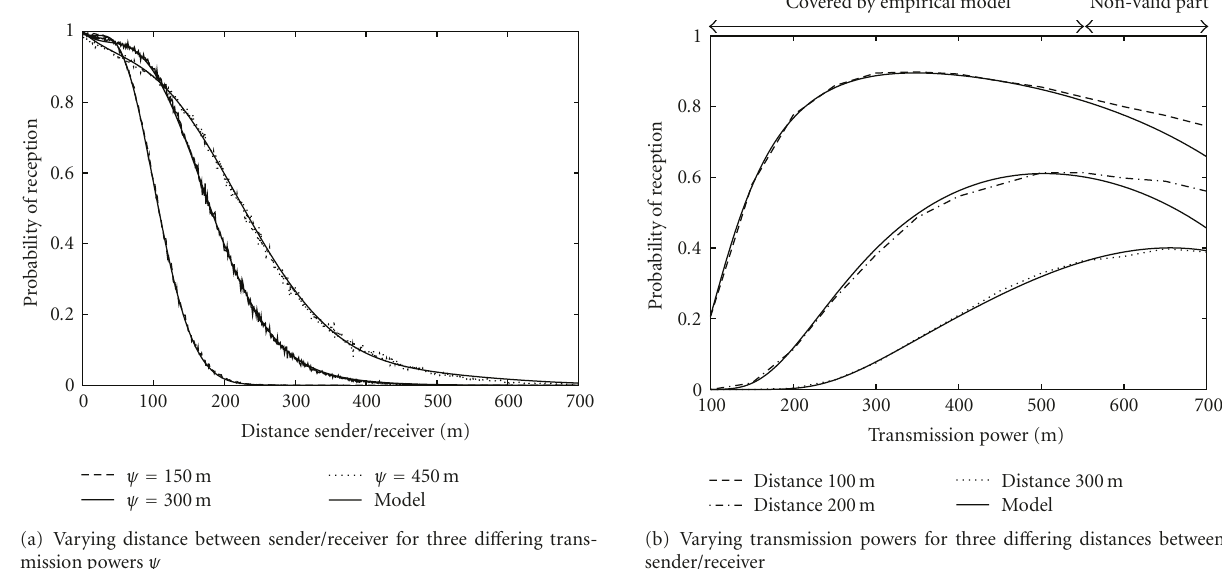
(b) Varying transmission powers for three di ff ering distances between sender/receiver Figure 7: Comparison of model to simulated scenario. The scenario involves a tra ffi c density of δ = 150 veh/km all transmitting at a rate of f = 6Hz. The simulation traces were not included in the model-building process.